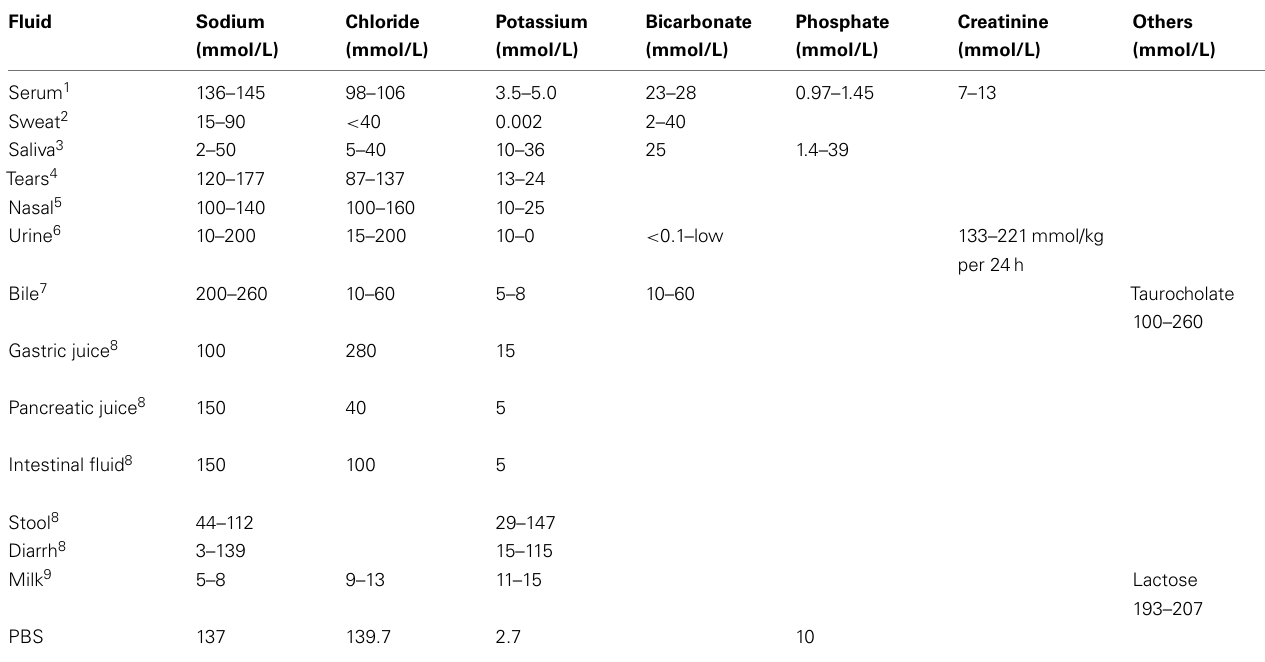
Table 1 | Electrolytes concentration and major components in different human